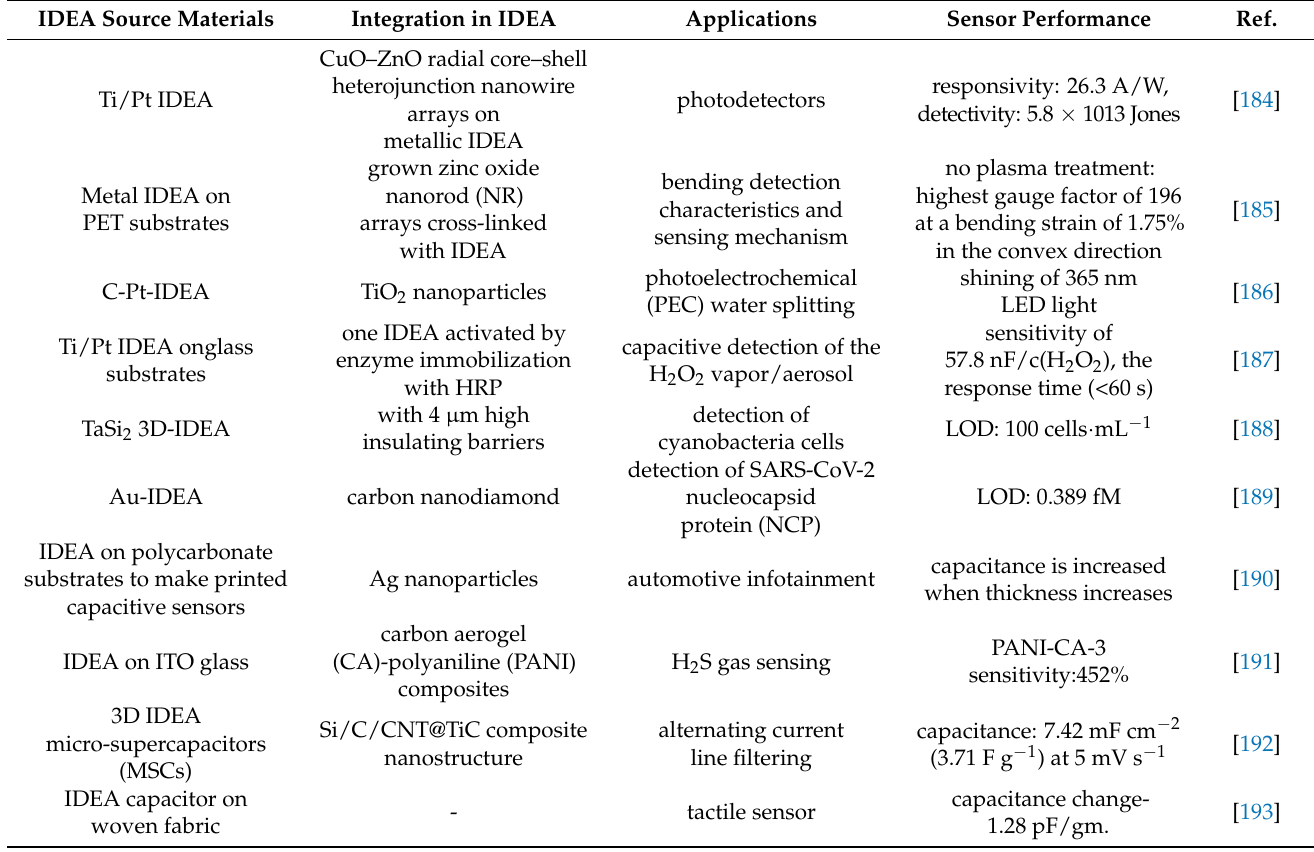
Table 4. Integration of IDEA with nanomaterials and various source materials for wide ranging applications between years 2021 and